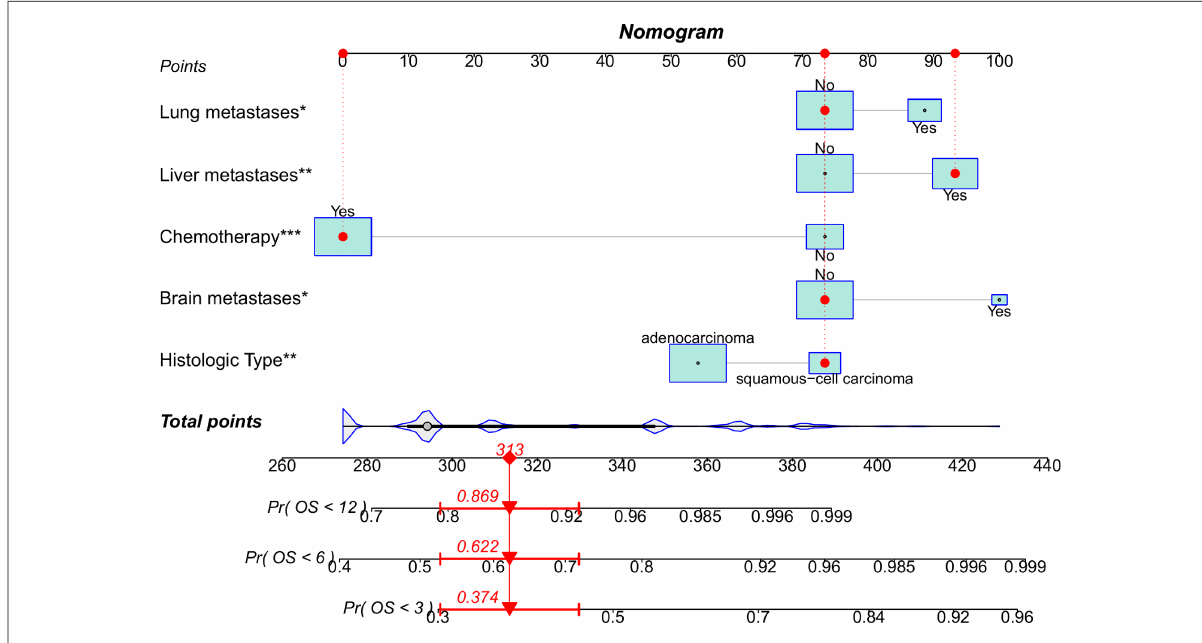
FIGURE 5 Nomogram to predict survival probability of EC patients with BM. A random patient was used as a demonstration. The red dot corresponds to the points of each predictor, and the red arrow below represents the probability of overall survival at 3, 6, and 12